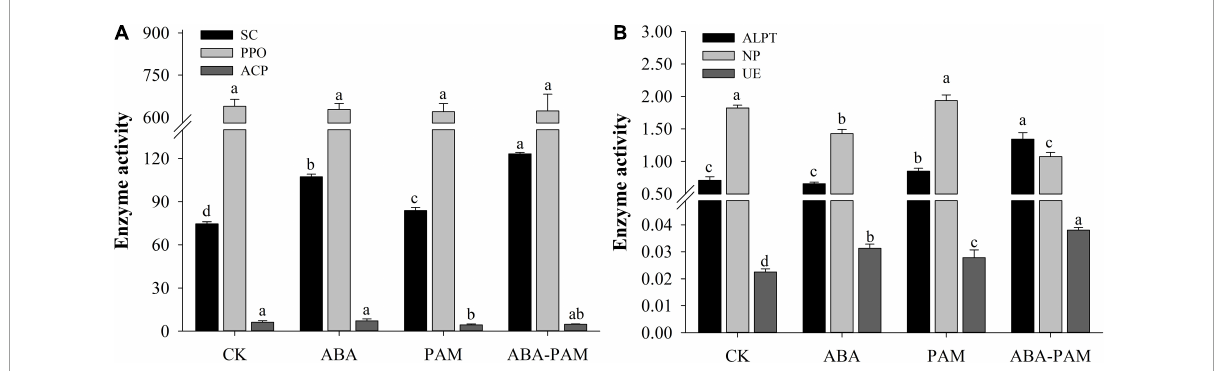
FIGURE2 Effect of ABA-PAM combined treatment on soil invertase (SC), acid phosphatase (ACP), neutral phosphatase (NP), polyphenol oxidase (PPO), urease (UE) and protease (ALPT). After the trea tment period (63 days), soil samples were collected for the analyses of soil enzyme activities. (A) Activities of SC, PPO, and ACP; (B) Activities of ALPT, NP, and UE.